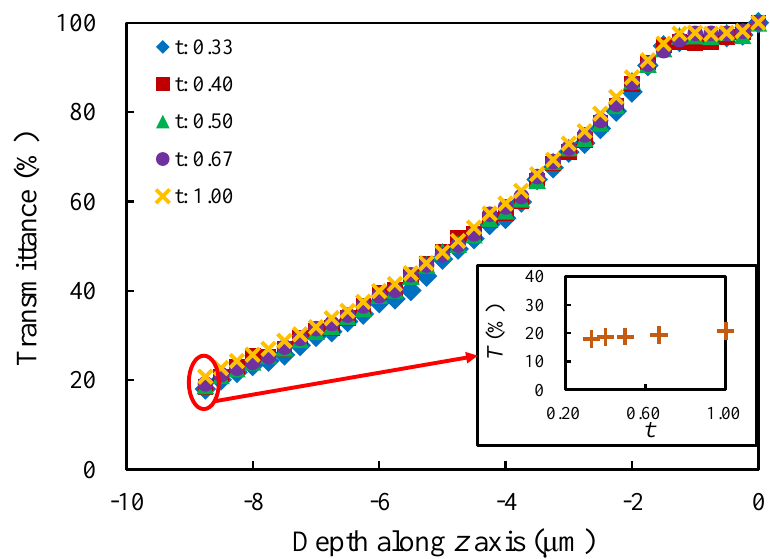
Figure 13. Evolution of the transmittance with the depth along z axis for the models with different diameter ratios.